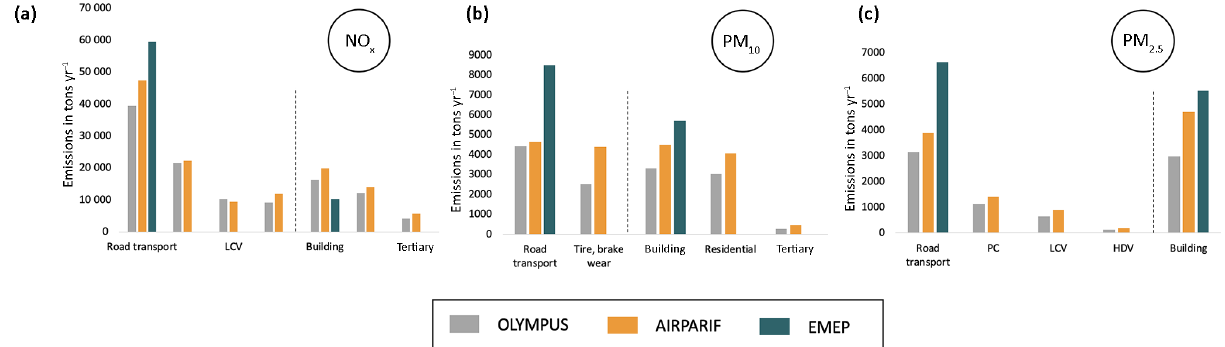
Figure 13. Emissions comparison with local and regional inventories for (a) nitrogen oxides, (b) particulate matter with a diameter of 10µm or less, and (c) fine particles with a diameter of 2.5µm or